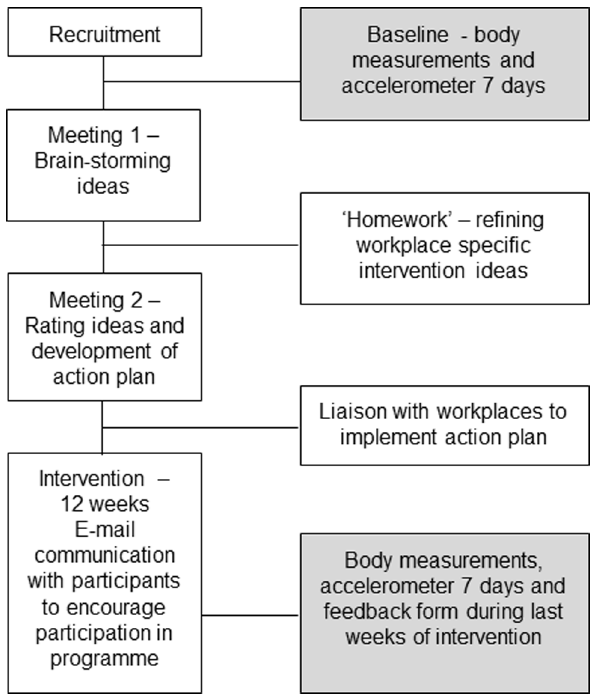
Figure 2. Diagram of the flow of procedures involved in each